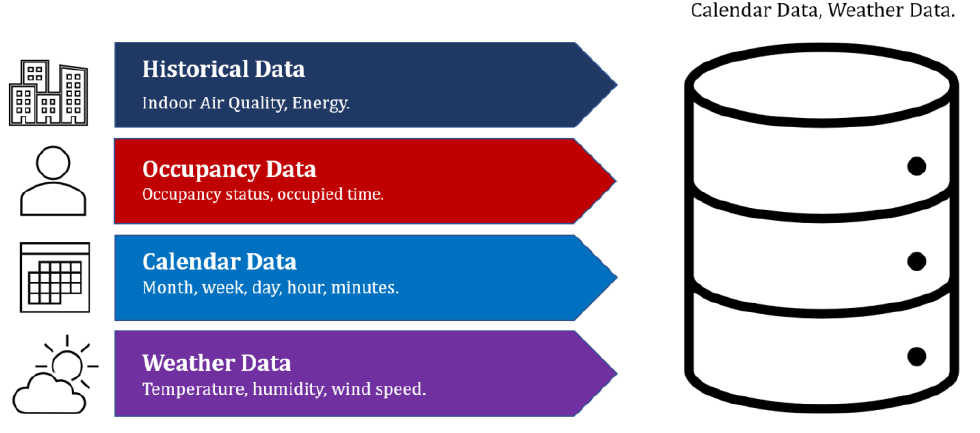
Figure 2. Building forecasting input variables.